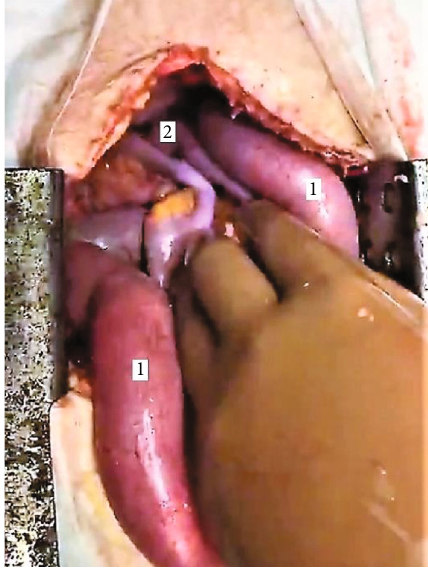
Figure 4: Intraoperative photo during reoperation. Dilated intestinal loops up to the level of distal ileum (1) are observed. The loop of a strangulated bowel (2) was adherent to the stump of the rectum and vagina deep inside the pelvic cavity.